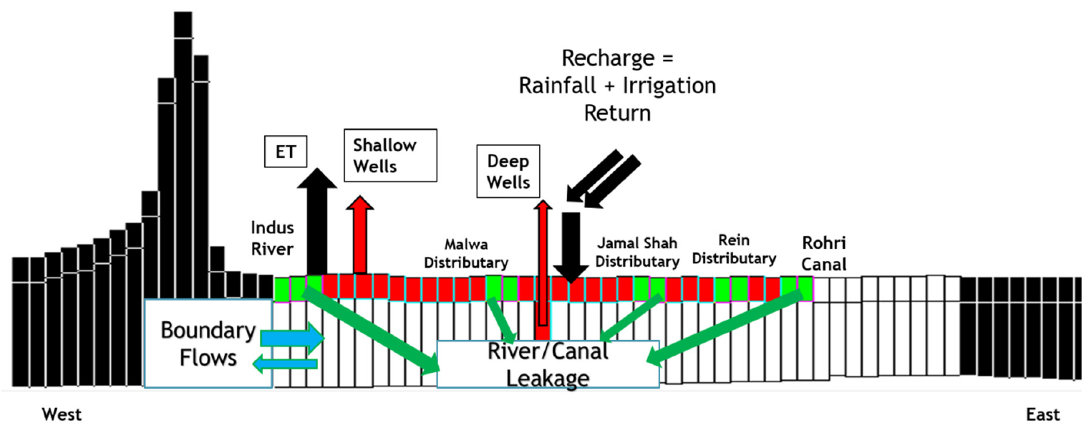
Figure 3. Conceptual cross-section of the model.